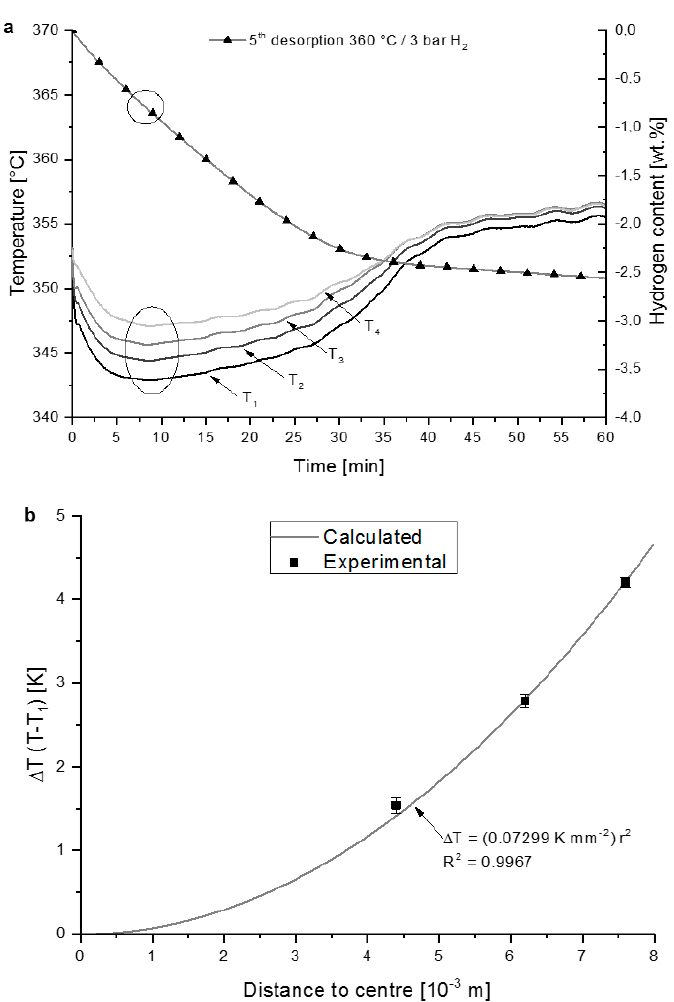
Figure 5. Thermal conductivity plotted against temperature from room temperature to 175 °C in Ar atmosphere for materials in absorbed (LiBH 4 /MgH 2 ) and desorbed (LiH/MgB 2 ) state together with an extrapolation for T > 175 °C.